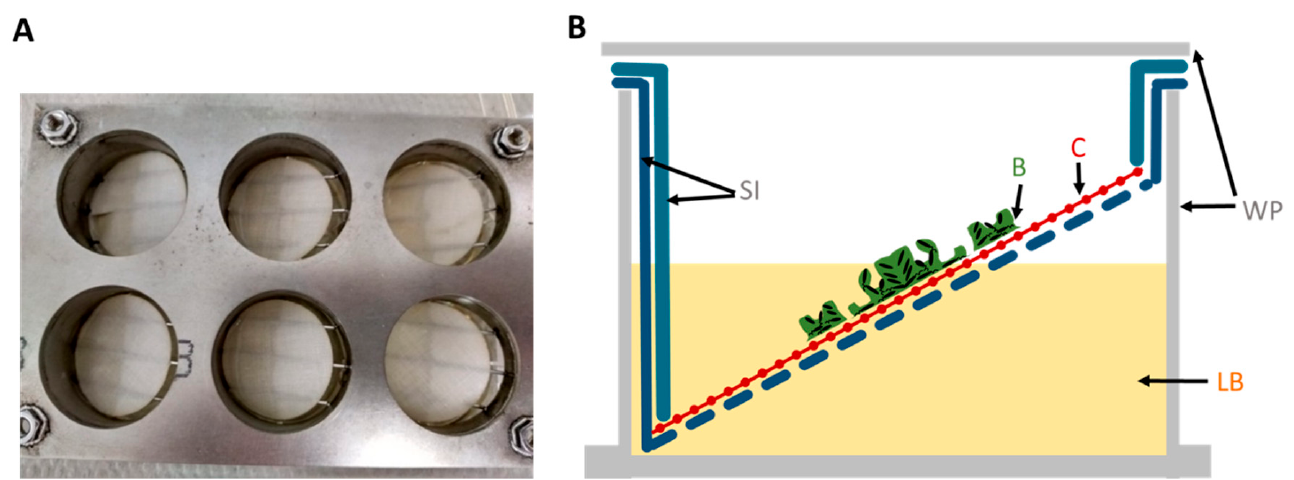
Figure 1. Setup of the stainless steel 6-well plate growth platform to grow Pseudomonas biofilms on woven fabrics. ( A ) Photograph from top of the 6-well stainless steel insert that clamps the cellulose substrate. ( B ) Schematic of one 6-well plate from the side view. LB covers only half of the substrate, so that the Pseudomonas biofilm can grow at the liquid–air interface. WP—well plate; LB—culture